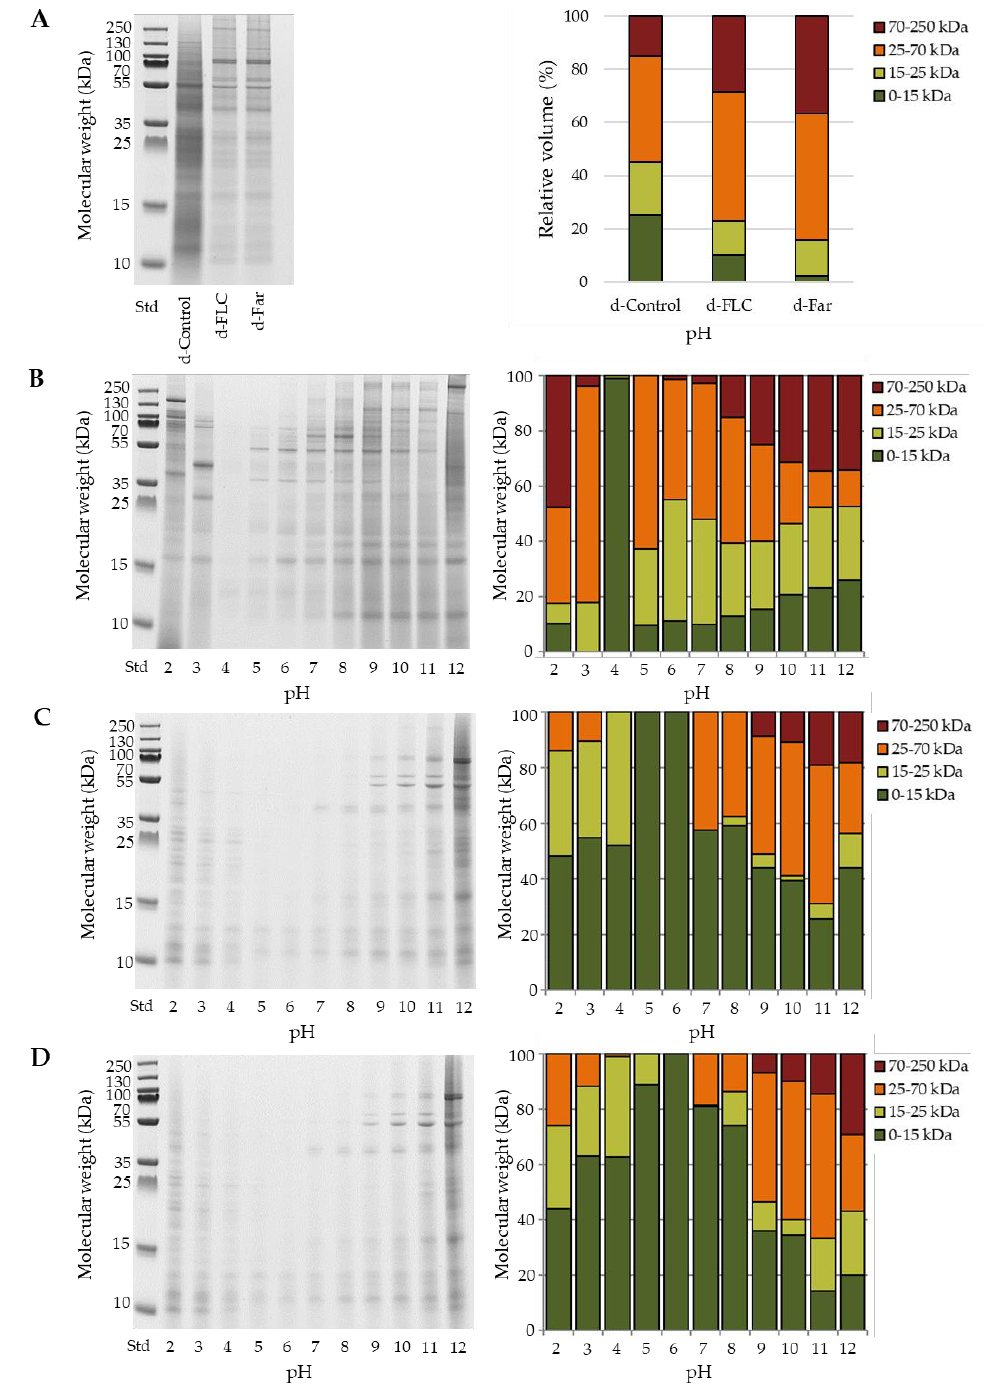
Figure 5. Gel electrophoresis (left) and relative composition (right) of mealworm powders ( A ) and soluble mealworm protein fractions (Control: regular mealworm paste ( B ), d-FLC: mealworm paste fermented with the starter Bactoferm ® F-LC ( C ), and d-Far: mealworm paste fermented with the starter L. farciminis ( D ) at different pHs. Proteins are classified in four groups: Low molecular weight (0–15 kDa), medium molecular weight (15–25 kDa and 25–75 kDa), and high molecular weight (70–250 kDa).